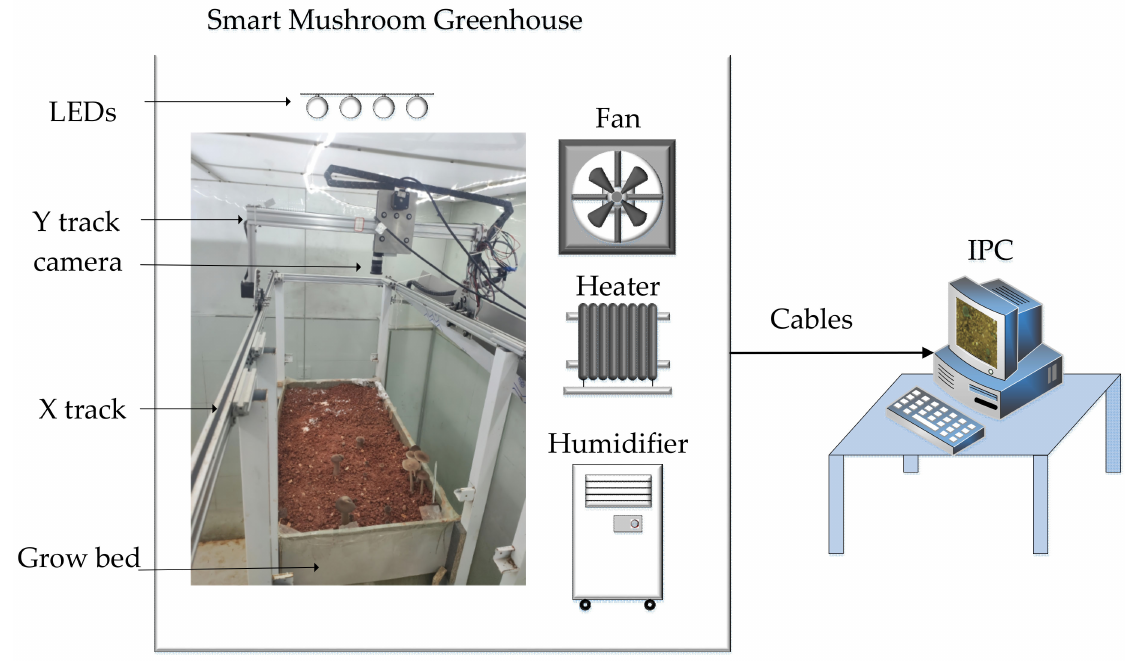
Figure 1. Image acquisition system in the mushroom greenhouse.